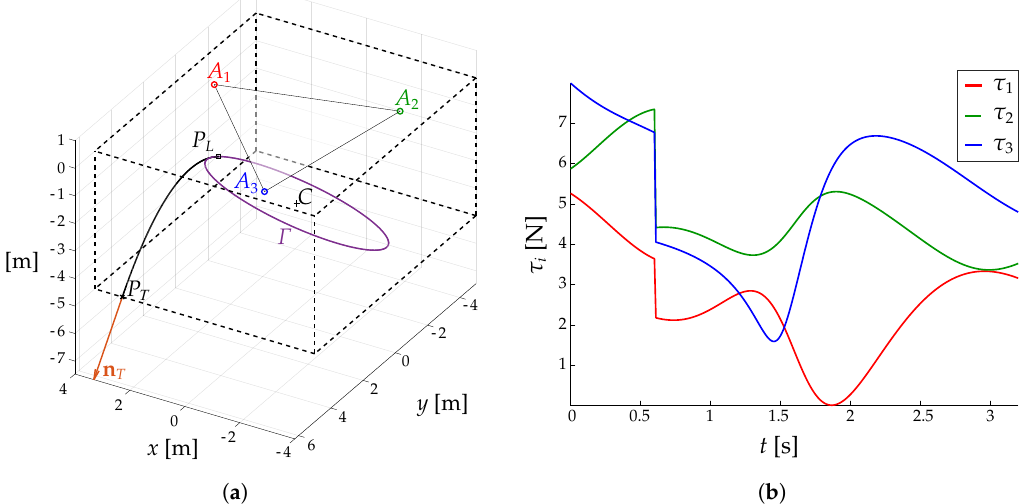
Figure 4. ( a ) Optimal trajectory: 3D view of the path Γ opt . ( b ) The cable tensions along Γ opt